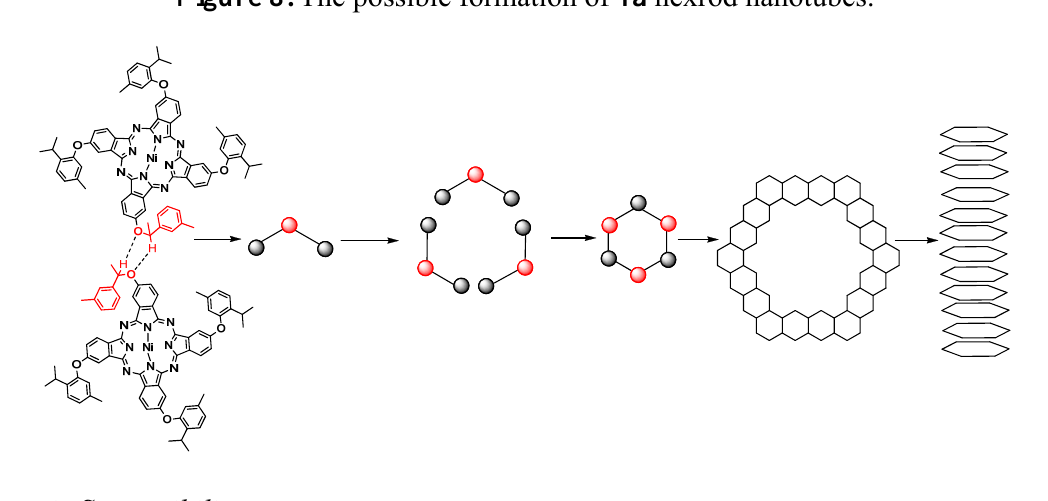
Figure 8. The possible formation of 1a hexrod